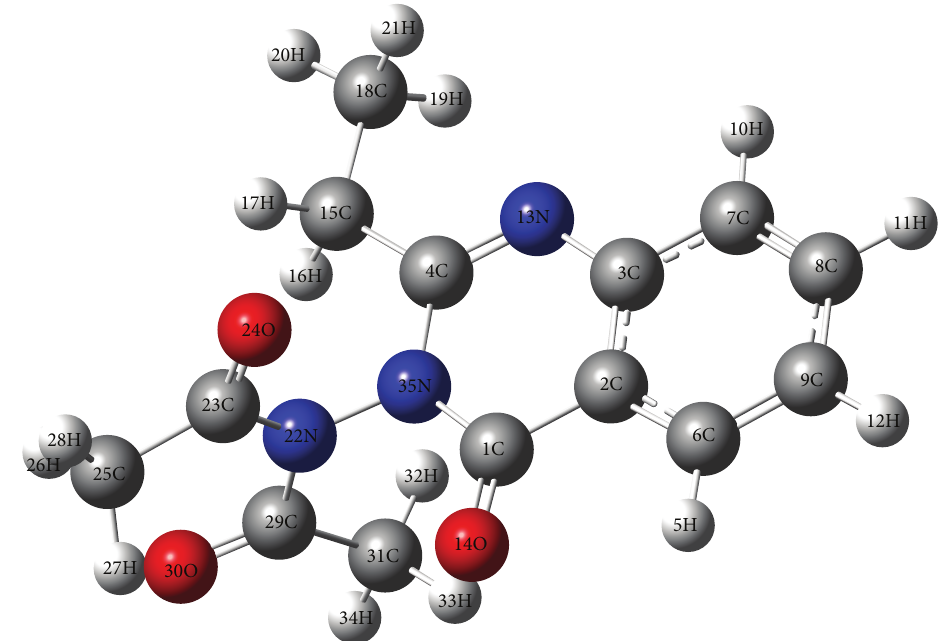
Figure 1: The optimized molecular structure of compound 2